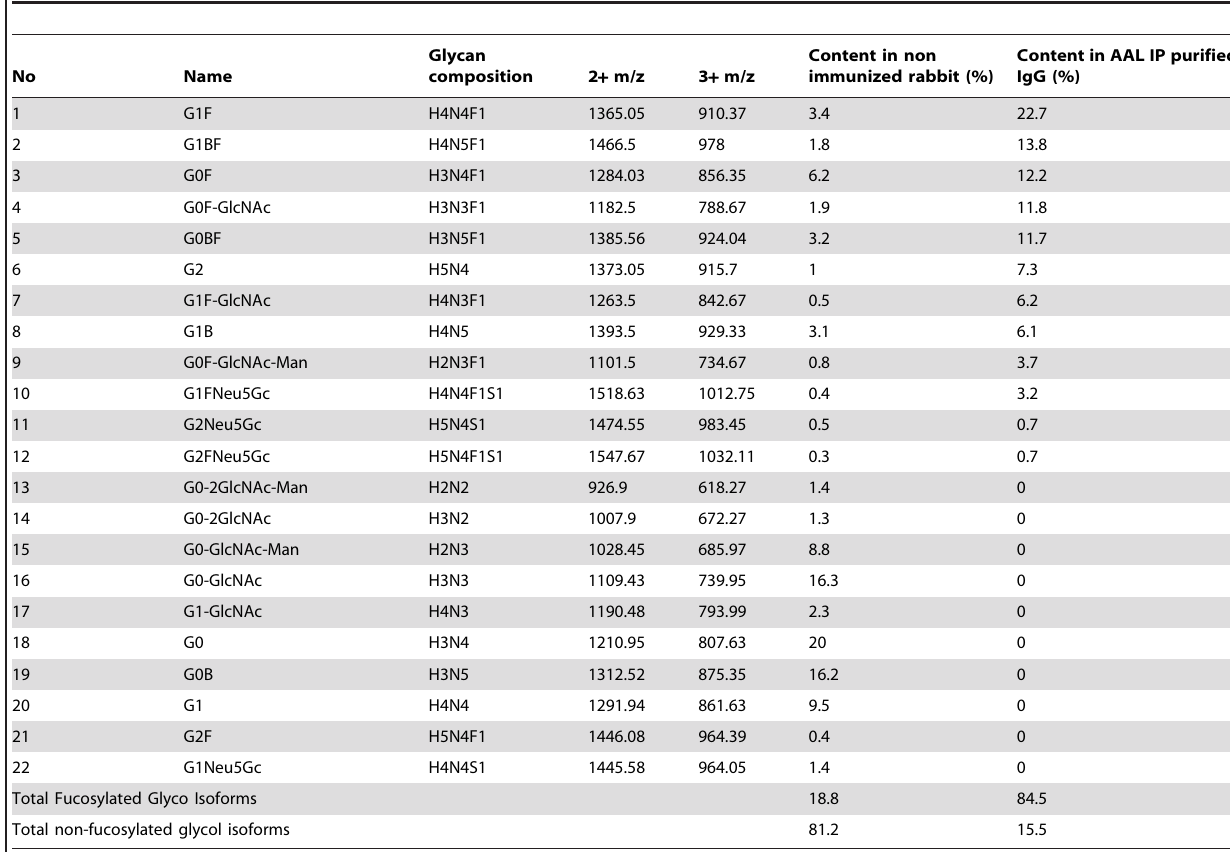
Table 2. Fc glycoforms of total IgG purified from Day 0 serum sample and AAL-reactive IgG purified from Day 9 sample of OVA- inoculated rabbit (rabbit # 4) were identified and quantified by using mass spectrometry